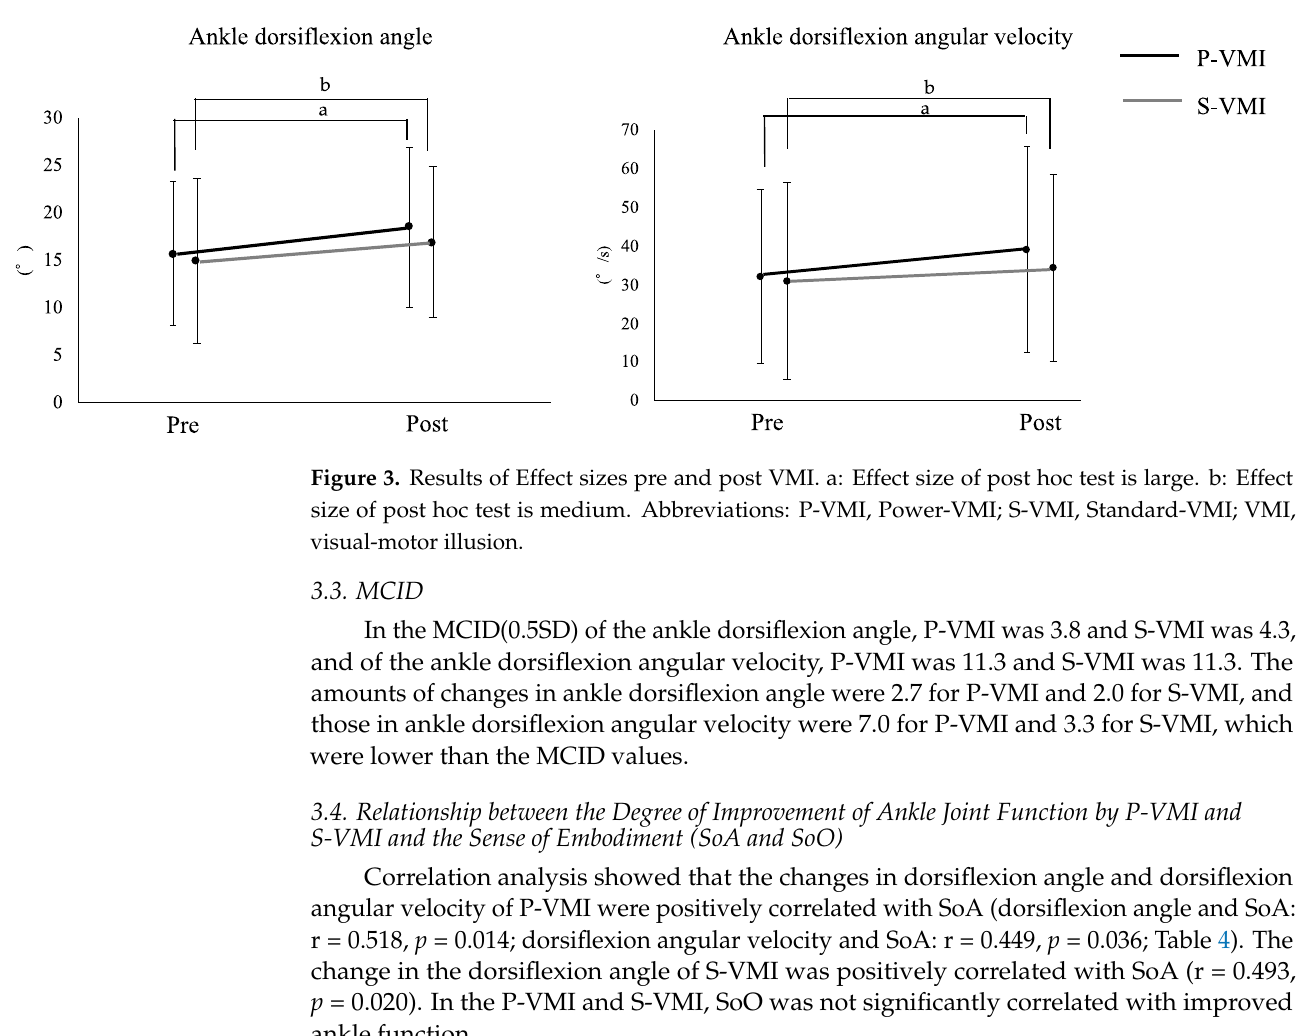
Table 4. Results of correlation analysis between degree of improvement in ankle dorsiflexion func- tion by VMI and various variables.